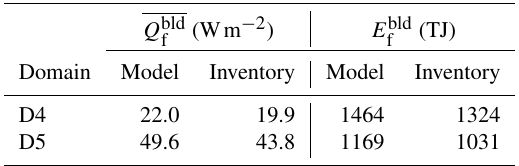
Table 2. Average anthropogenic heat flux due to building energy ) and total building energy consumption ( E bld consumption ( Q bld f